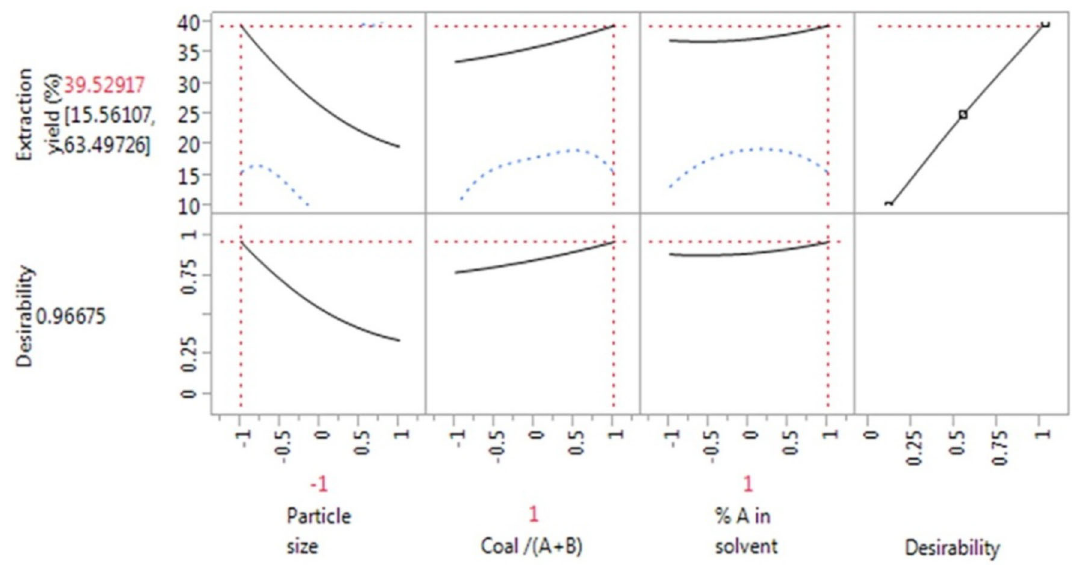
Fig. 3 Prediction profiler showing the variation of extraction yields with different parameters and the maximum desirability